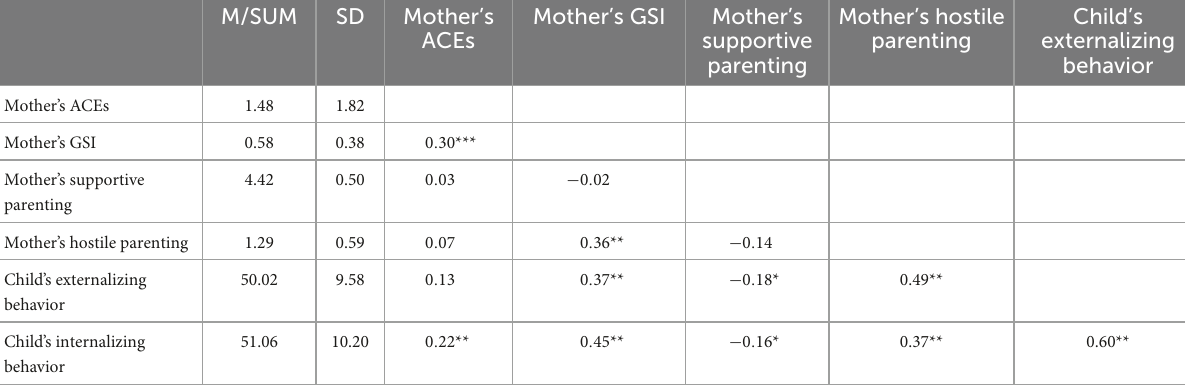
TABLE 1 Descriptive statistics of the study’s variables and their intercorrelations ( N =